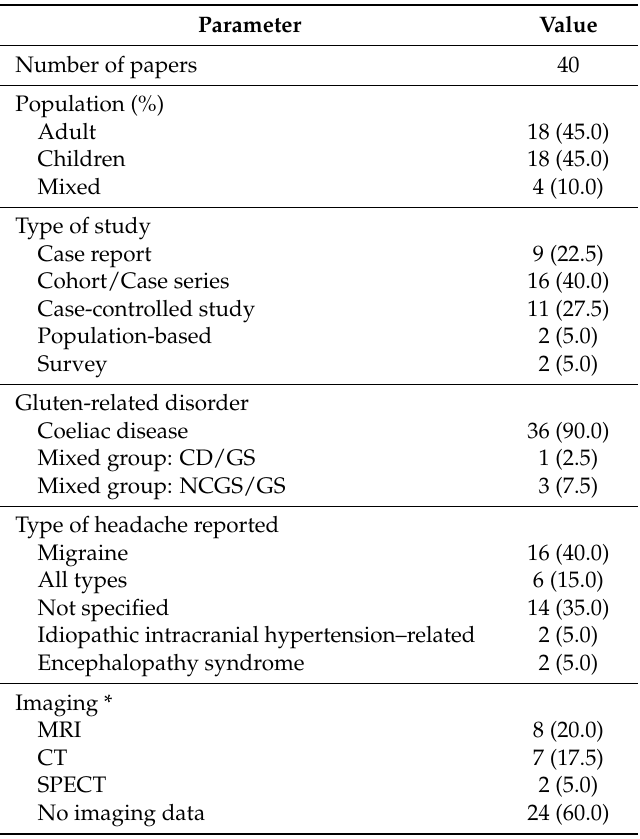
Table 1. Descriptive of studies included in the